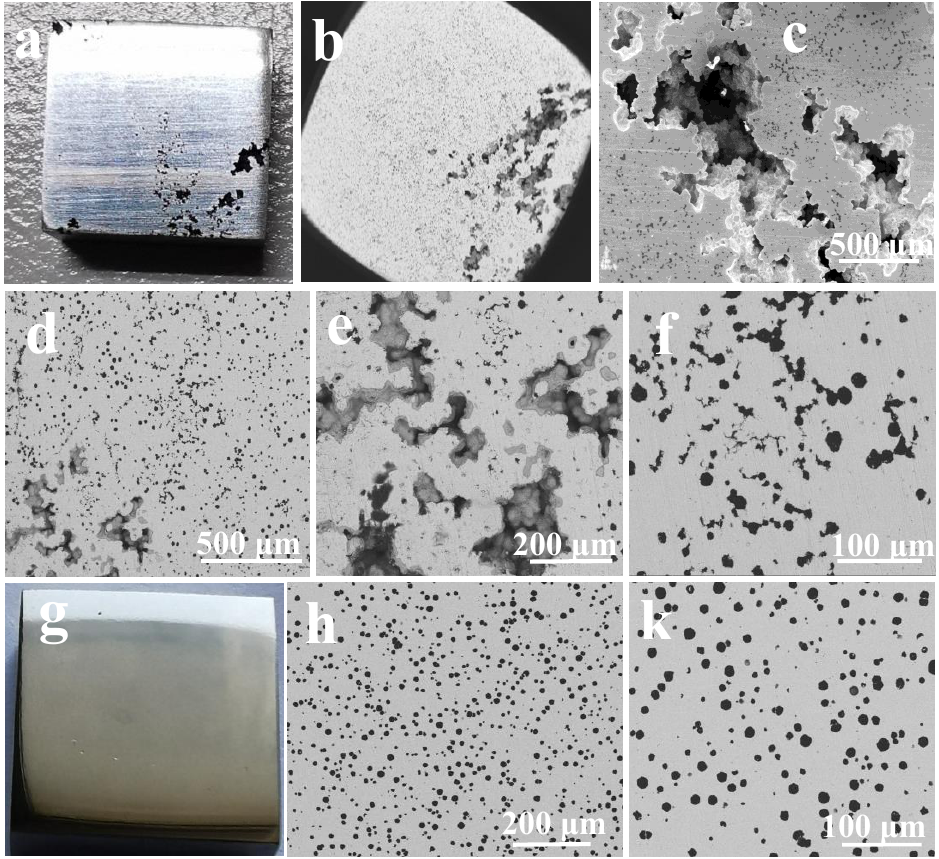
Figure 1. The microscopic morphology of the two ductile iron samples before the experiment. ( a ~ f ) ductile iron pipe with no surface mechanical treatment, ( g ~ k ) ductile iron pipe with surface mechanical treatment.